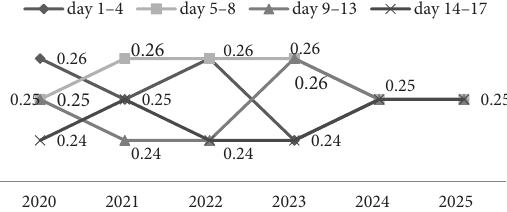
Figure 3. Forecasted number of enrolled students between